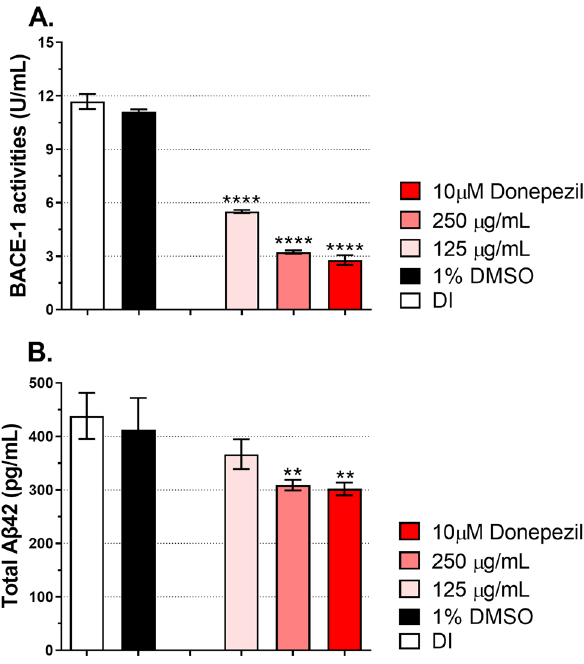
Figure 1. Effect of the ethanolic extract of D. esculentum on ( A ) BACE-1 activities and ( B ) Aβ42 accumulation in the Drosophila models of AD. AD-free flies (elav-Gal4) were cultured on a normal medium, and AD flies (APP-BACE-1) were cultured on a medium containing deionized water (DI), 1% DMSO, 125 µg/mL and 250 µg/mL of D. esculentum and 10 µM donepezil for 28 days before assay for either BACE-1 activities or Aβ42 levels. Values are mean ± SD of three assays and statistical significance was analyzed against AD flies (DI) by one-way ANOVA followed by Tukey’s test. **, p < 0.01) and ****, p < 0.0001.